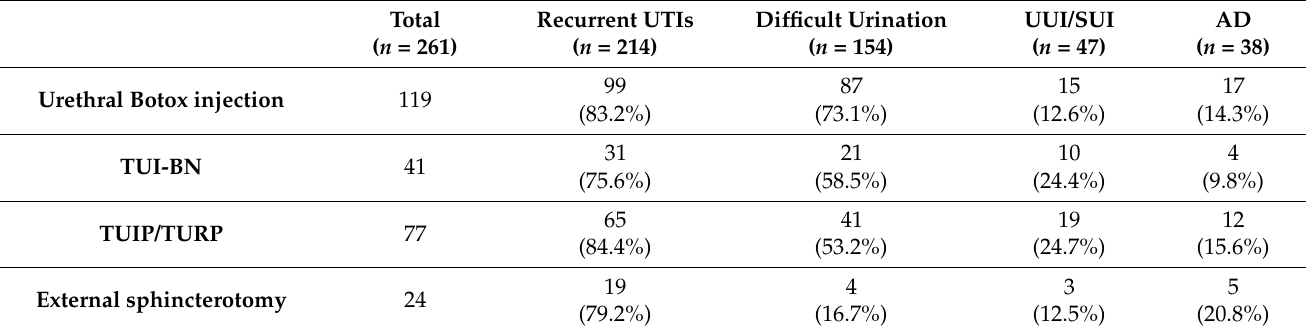
Table 5. Causes of dissatisfaction with bladder management after initial treatment for spontaneous